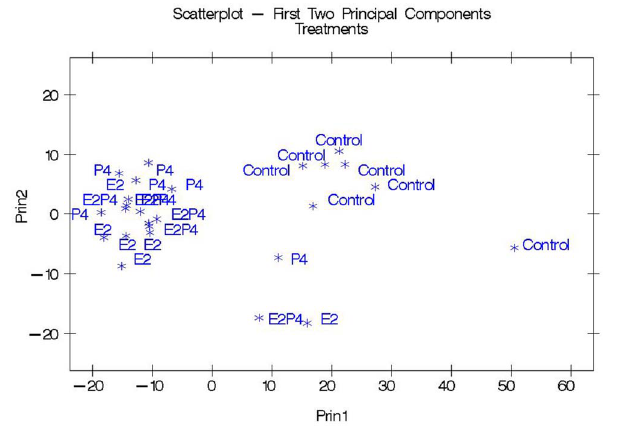
Figure 3. Principal component analysis. Principal component analysis (PCA) using gene expression measurements from 592 genes selected based on significance level ( P , 0.01). Control samples (CO) clustered effectively separated from the estradiol-17 b (E2), progester- one (P4) and estradiol-17 b + progesterone (E2P4T) treated samples.